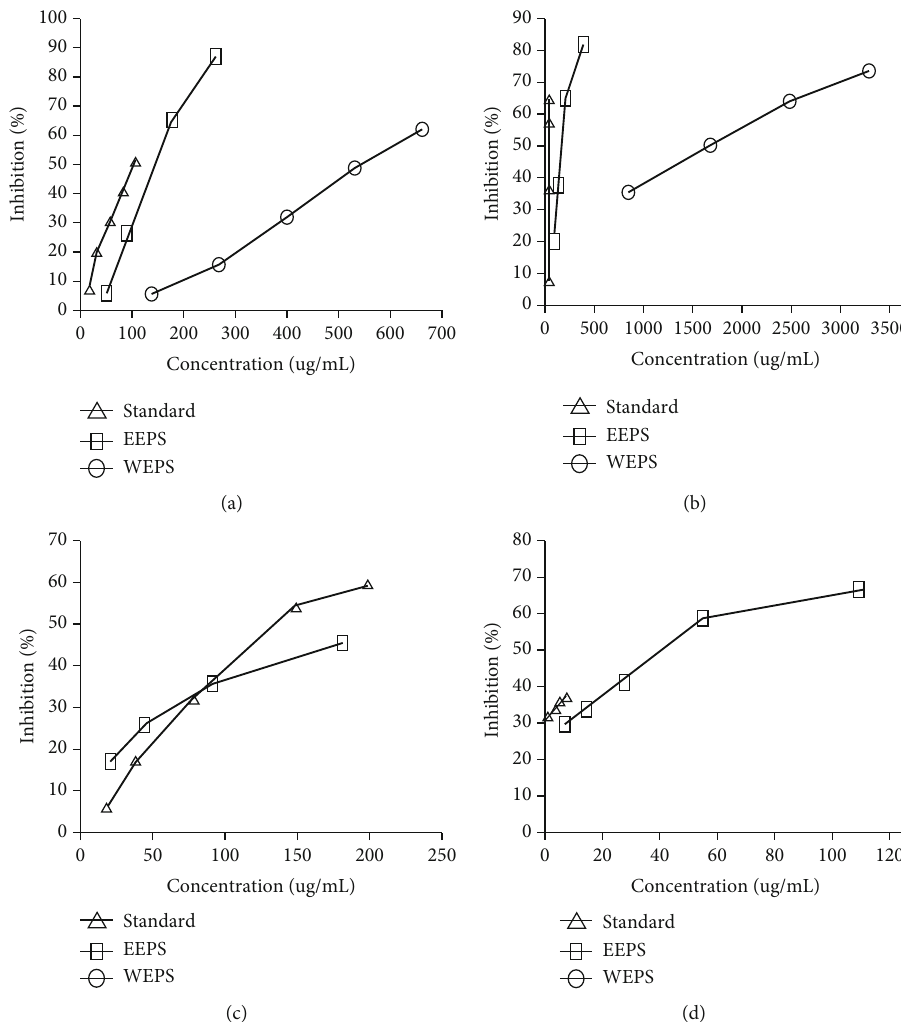
Figure 2: Concentration-response curves for the inhibition of EEPS, WEPS, and controls on (a) α -glucosidase, (b) α -amylase (c), xanthine oxidase, and (d)